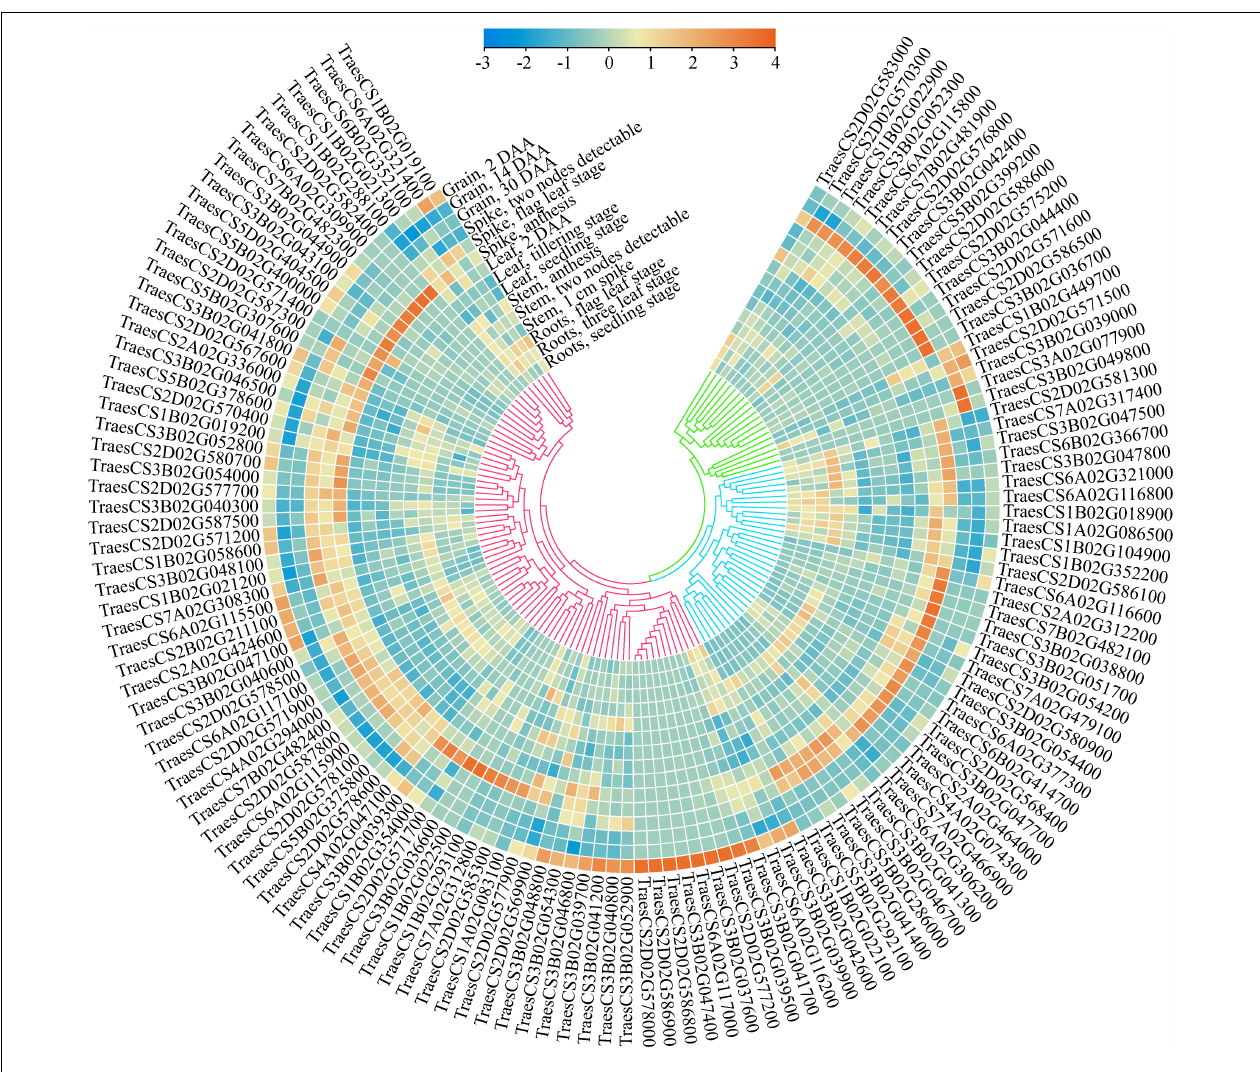
FIGURE 5 | Expression characteristics of 134 putative candidate genes in five tissues. The transcriptome data was downloaded from expVIP (http://www.wheat-expression.com), and TPM value was used to characterize the expression level based on normalized scale